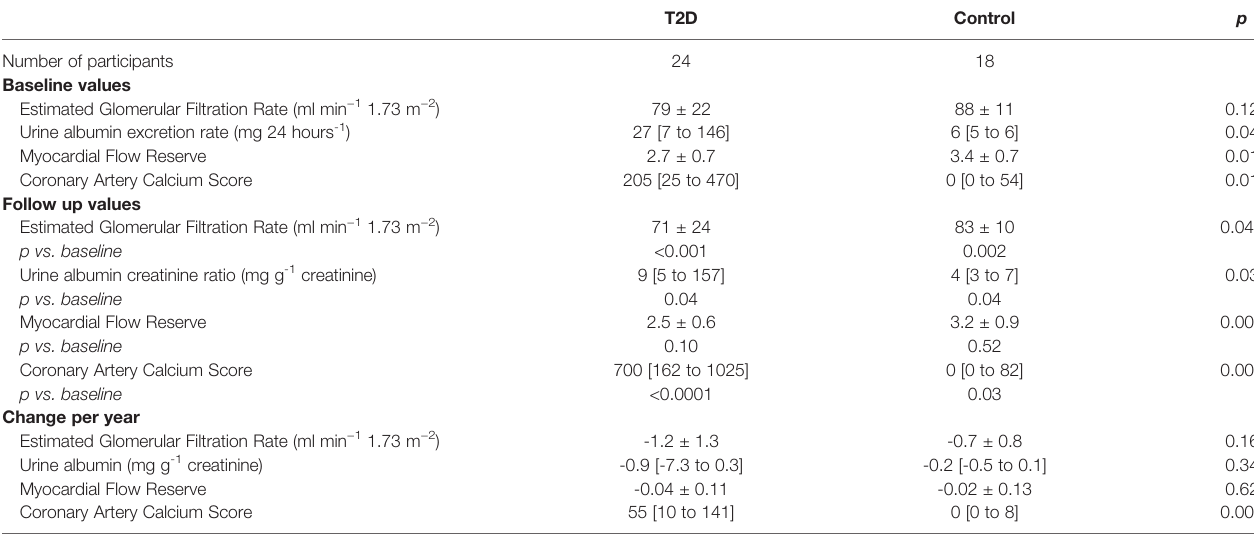
TABLE 2 | Baseline and follow up values of